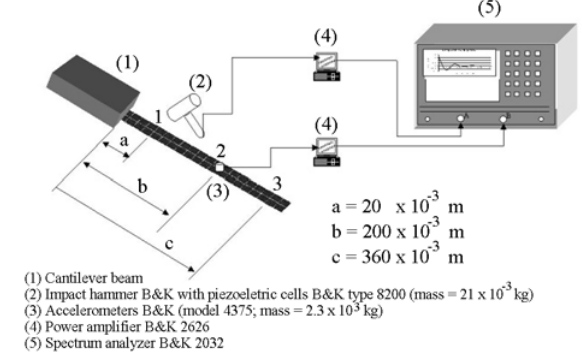
Figure 3. Impulse testing.